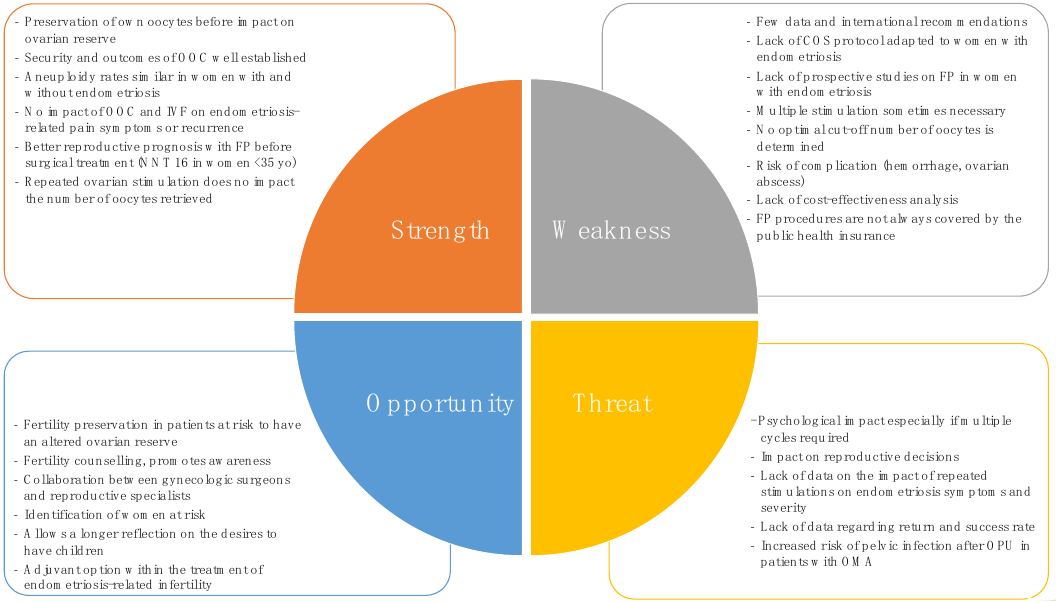
Figure 3. SWOT analysis of oocyte cryopreservation in women with endometriosis. Adapted from I. Streuli et al. [45]. OOC: oocyte cryopreservation, FP: fertility preservation, NNT: number needed to treat, yo: years old, COS: controlled ovarian stimulation, POF: premature ovarian failure, AMH: anti-Mullerian hormone.